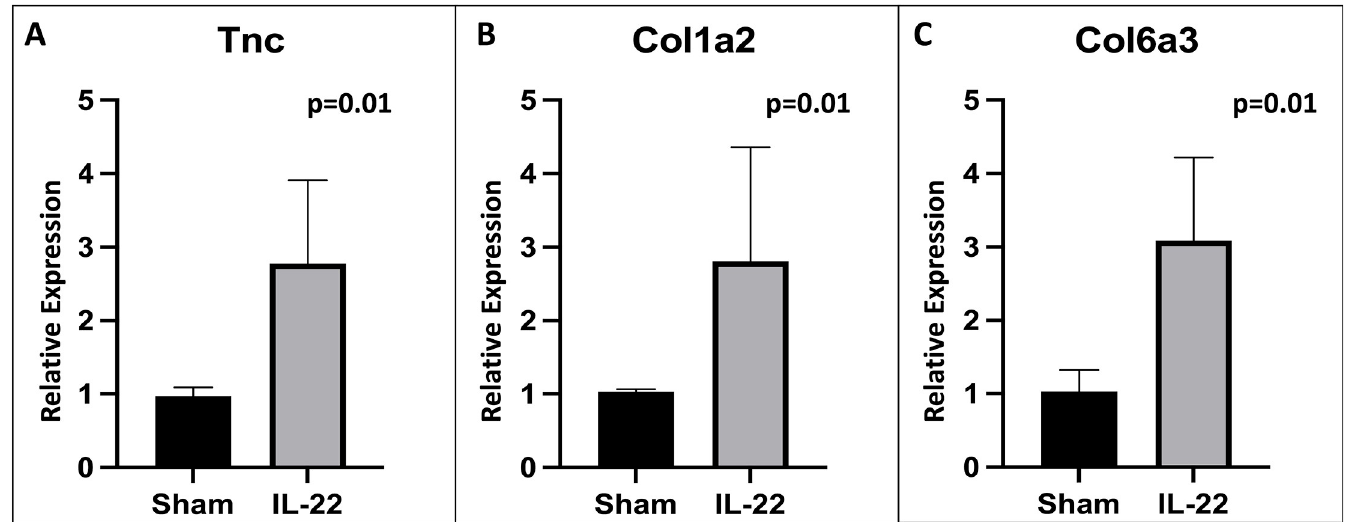
Fig 10. Qualitative PCR showing increased expression of extracellular matrix components in IL-22:Fc treated animals. Increased expression of A) Tenascin C (Tnc), B) collagen, type I, alpha 2 (Col1a2) and C) collagen, type VI, alpha 3 (Col6a3) in IL-22:Fc treated animals as compared to sham.